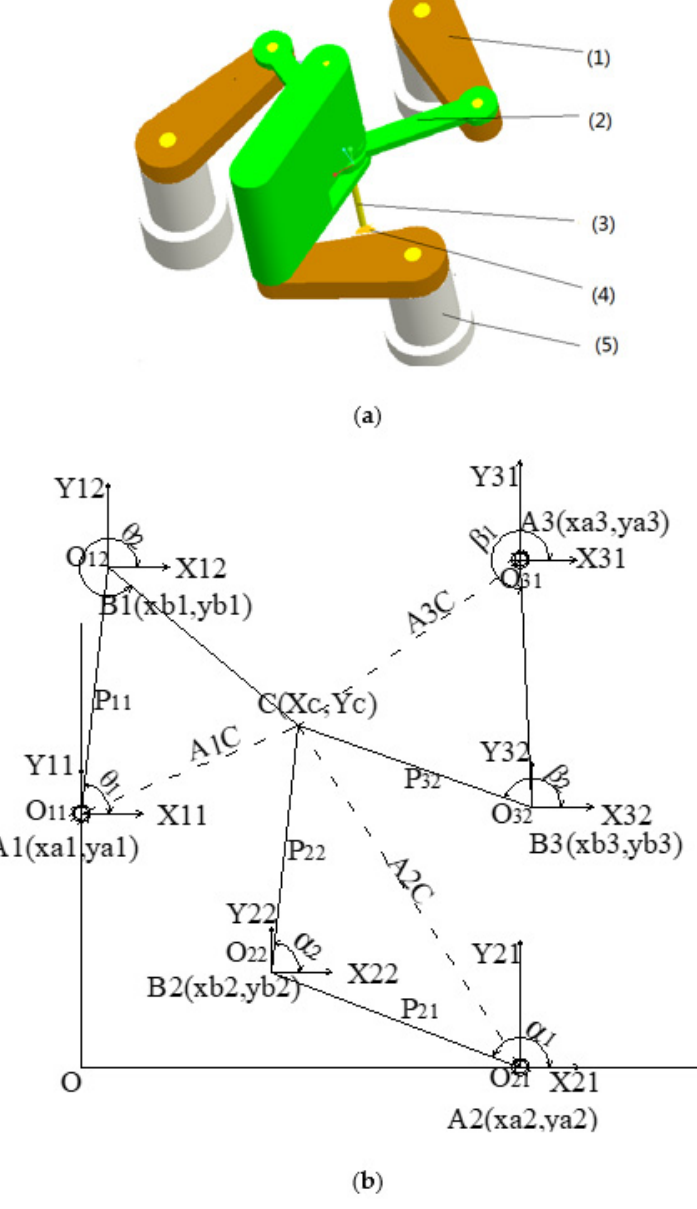
Figure 1. The structure of 4-DOF redundant parallel robot and the establishment of its coordinates system: ( a ) structure of robot, (1) driving arms, (2) driven arms, (3) end-effector, (4) pneumatic claw, and (5) plinth; ( b ) establishment of coordinates system.